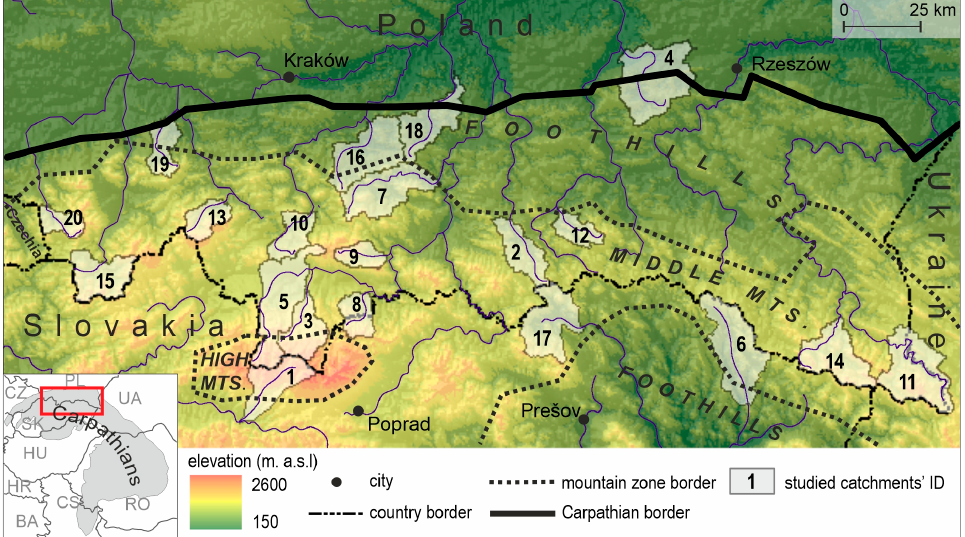
Figure 1. The studied catchments (catchment ID refer to Table 1). Table 1. Characteristics of the studied